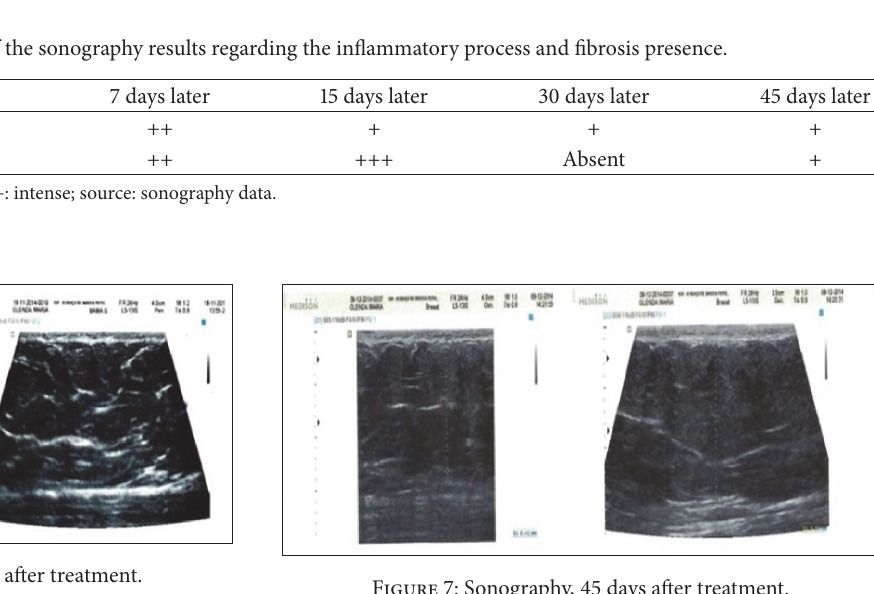
Figure 7: Sonography, 45 days after